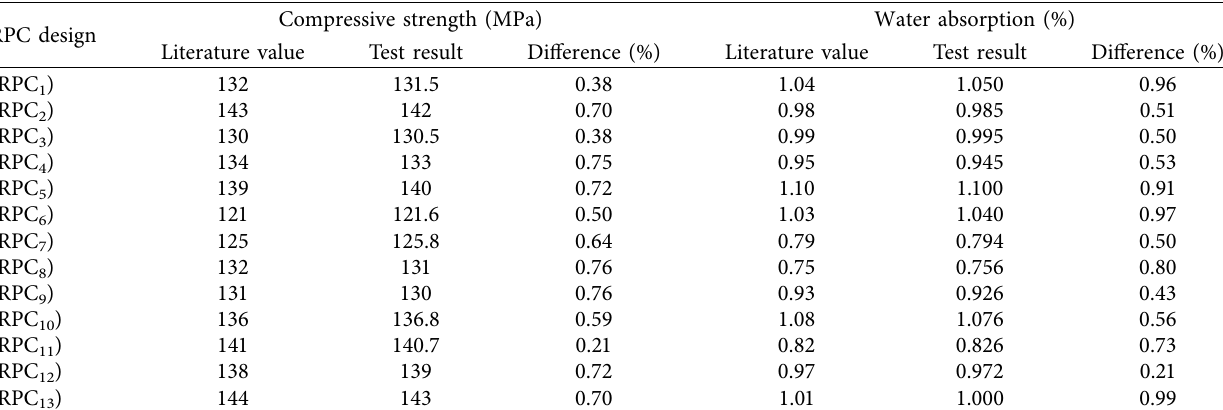
Table 7: Characteristics of RPC design samples in the experimental program.